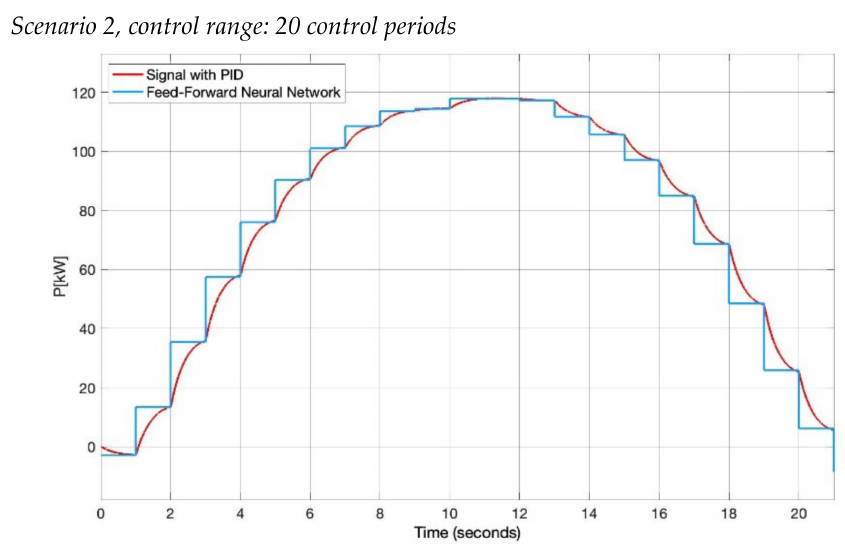
Figure 23. Control signal for BESS, p.f. = 0.95, SF—weekend.